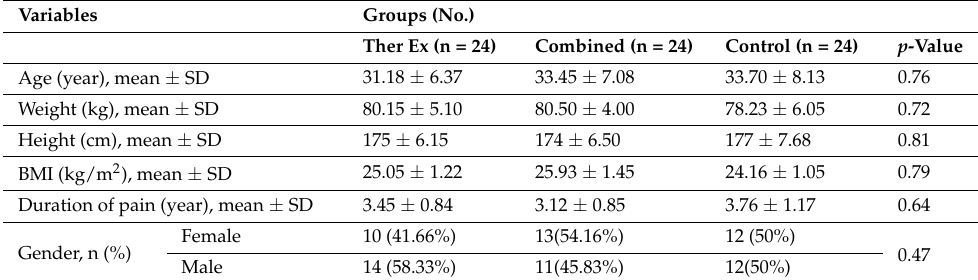
Table 2. Baseline sociodemographic